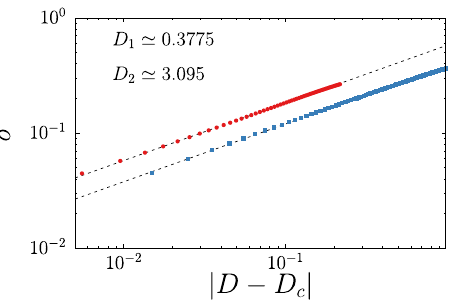
Fig. 4 Scaling behavior of the amplitude close to the bifurcation points. Dependence of the mean- fi eld oscillation amplitude σ on ∣ D − D 1 ∣ (red circles) and ∣ D − D 2 ∣ (blue squares) where D is the diffusion value, and D 1 ≃ 0.3775 and D 2 ≃ 3.095 are the critical points corresponding to the death and restoration of the oscillations respectively. Black dashed lines correspond to power laws with exponent β =